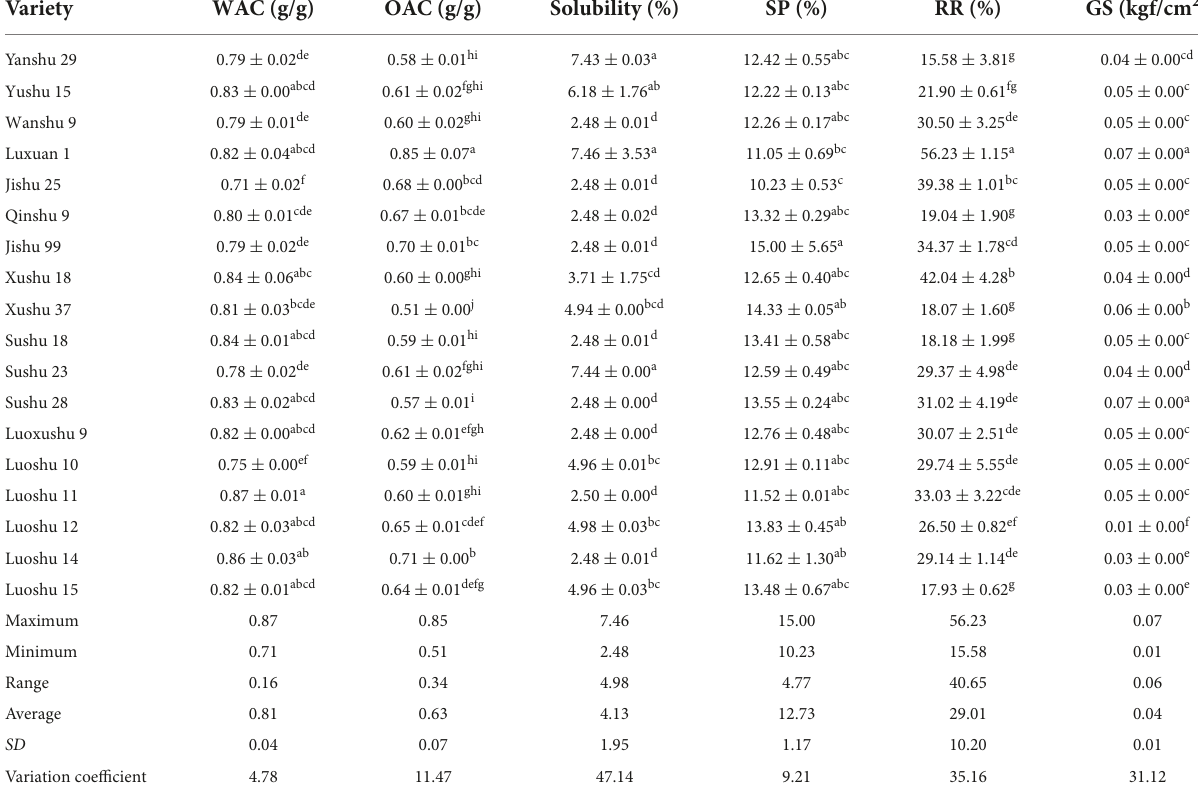
TABLE 4 The physicochemical properties of sweet potato starch.